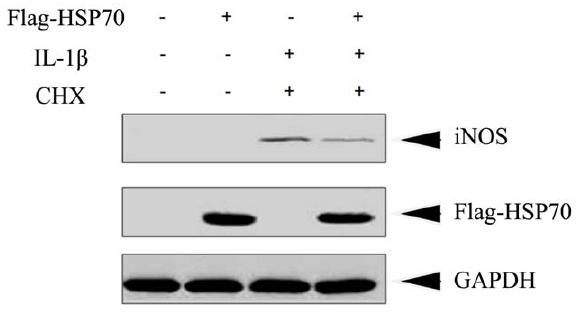
Figure 5. HSP70 overexpression inhibited IL-1 b -induced pro- duction of iNOS. HeLa cells were transfected with pcDNA3.0 ( 2 ) or pcDNA3.0-Flag-HSP70 ( + ) for 48 h and then stimulated with or without IL-1 b (10 ng/ml) plus CHX (1 m g/ml) for 4 h. Cells lysates were prepared and subjected to immunoblotting to measure protein level of iNOS. Antibody against Flag-tag was used to show the overexpression of HSP70 and equal loading protein was confirmed by GAPDH.